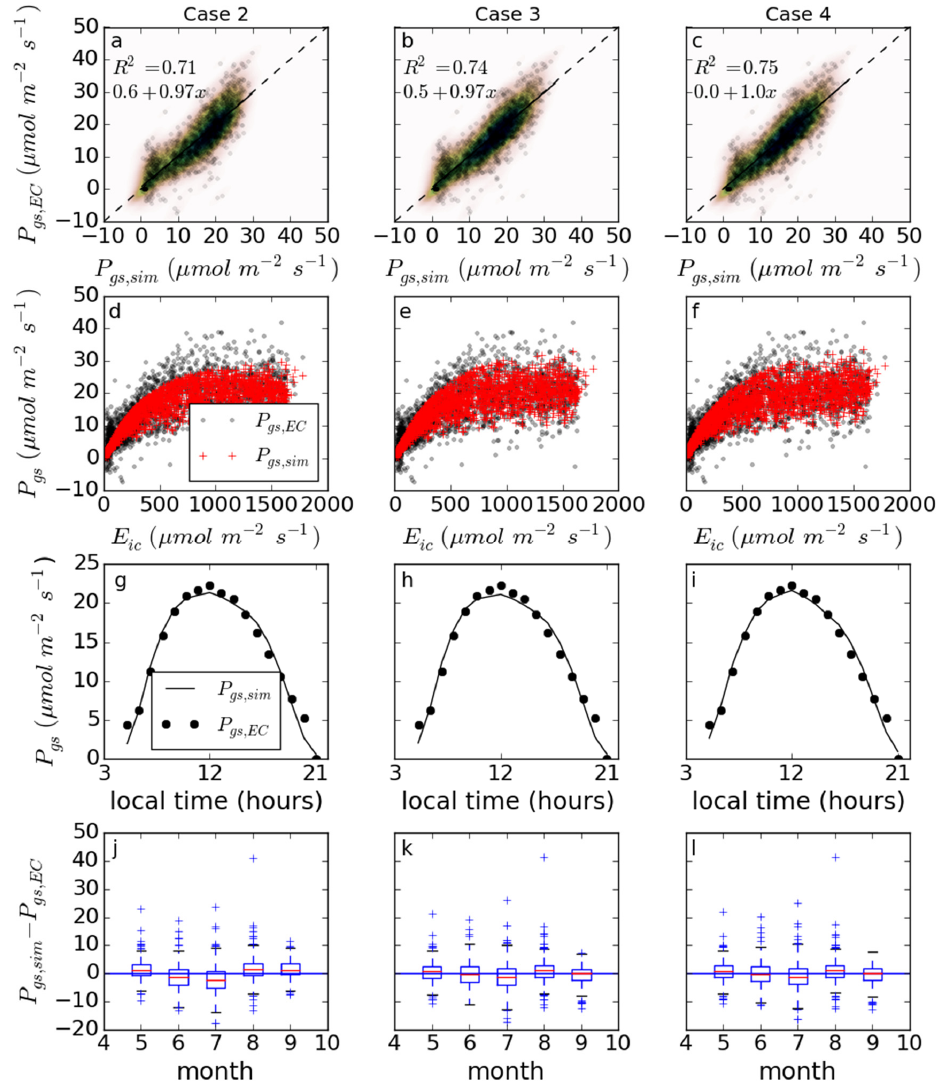
Figure 8. Three model inversion cases (2094 observations, no cross validation) using different modifier functions to downregulate the theoretical optimal photosynthetic capacity and quantum yield. Shown are the correlation with eddy-covariance derived gross primary productivity estimates ( a – c ); the distribution of measured and simulated estimates of gross primary productivity against incident photosynthetically active radiation ( d – f ); average diurnal responses ( g – i ); and seasonal variation in the residuals ( j – l ). See Table 1 and text for an overview of parameters used for the different cases and Table 2 for an overview of parameter estimates obtained through model inversion.